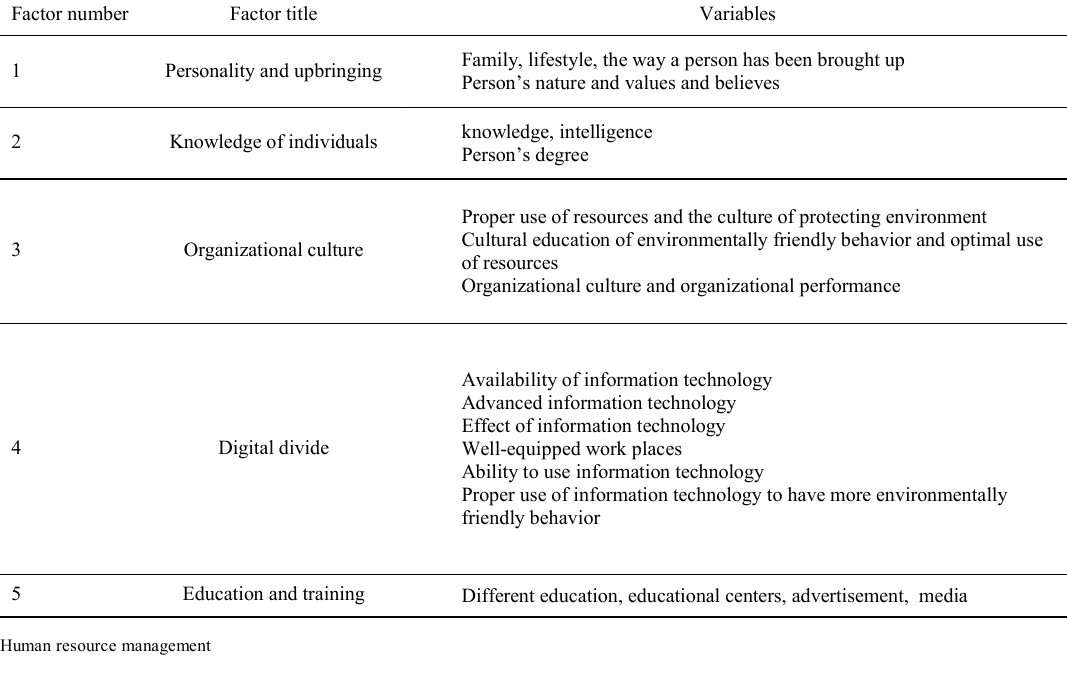
Table 1: Factors affecting Green HRM *